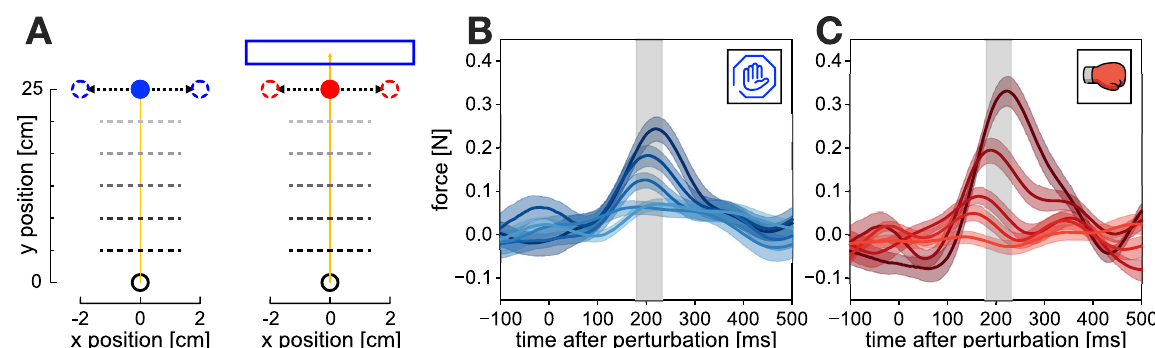
Fig 2. Experimental perturbations and responses. A . Perturbations in stop (left) and hit (right) conditions. Participants performed a forward reaching movement towards a target, positioned 25.0 cm in front of the start position. When the hand crossed one of five evenly spaced locations (dashed lines), a perturbation could be induced by shifting the target by 2 cm laterally for 250 ms and then returned back to the original position. Participants were instructed to either stop at the blue target (stop condition), or hit the red target and stop within the blue rectangle (hit condition). B . Net unscaled feedback responses to the target perturbations in the stop condition, measured via the force channel. Participants produced corrective responses to the target perturbations that varied by different perturbation onsets. Different traces represent different perturbation onsets, with darker colours indicating earlier perturbations. Shaded areas represent one standard error of the mean (SEM). The grey rectangle represents the time window of 180–230 ms, where the visuomotor feedback intensities are measured. C . Net unscaled feedback responses to the target perturbations in the hit